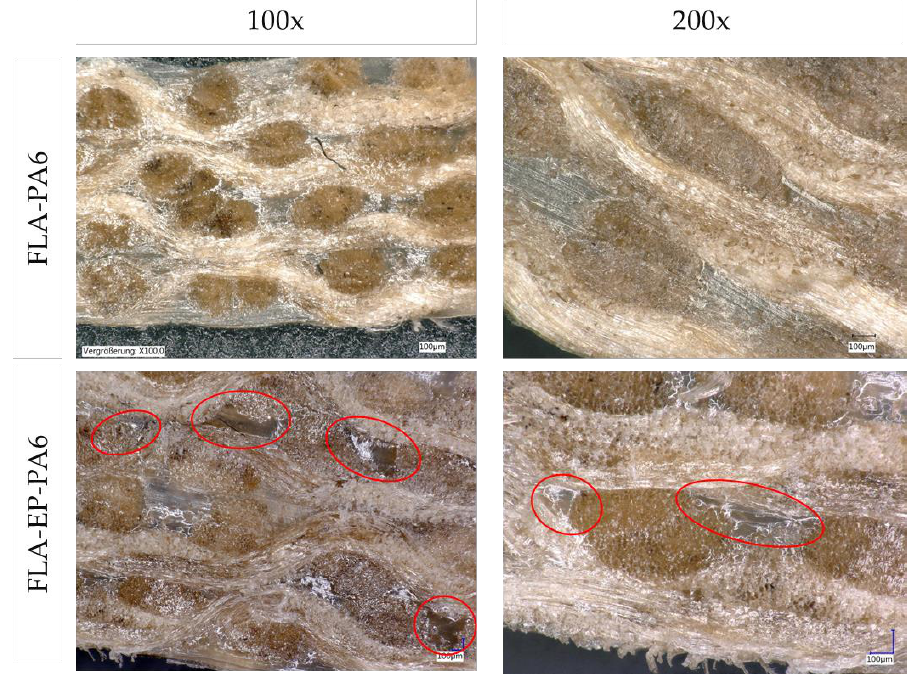
Figure 5. Digital microscope images of the cross-section of FLA-PA6 and FLA-EP-PA6 biocomposites.